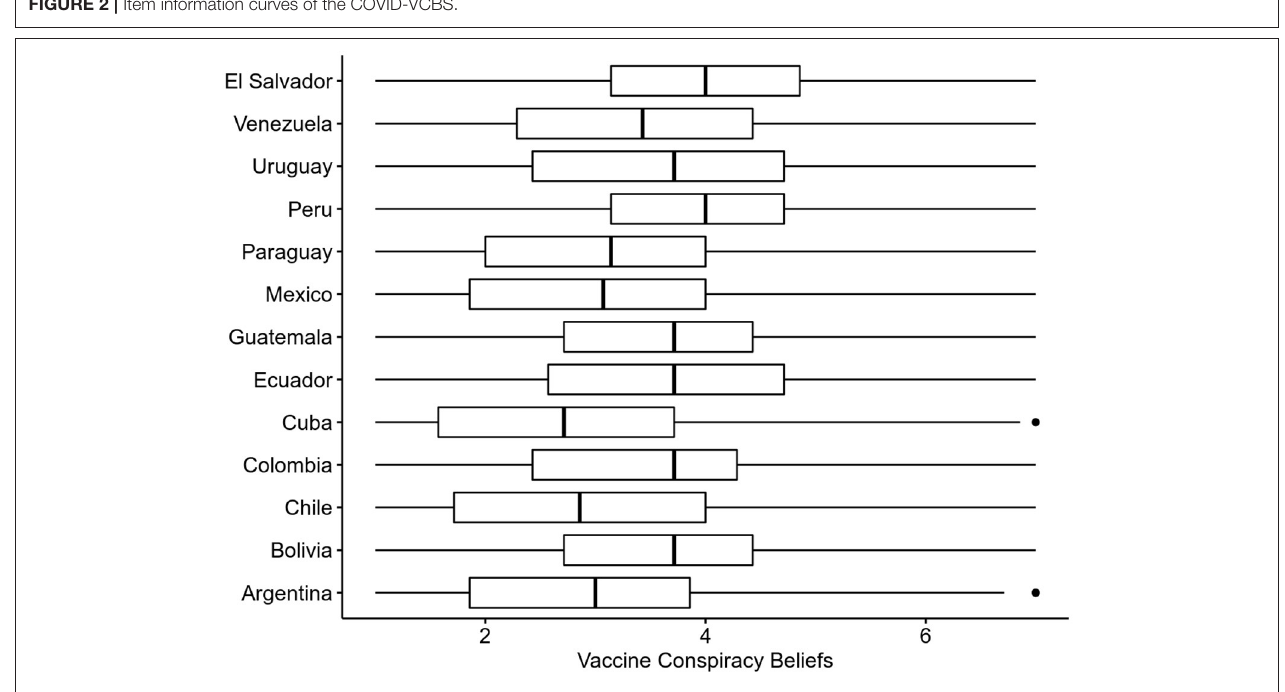
FIGURE 3 | Boxplots comparing the observed scores of the COVID-VCBS across countries. with data reported from other sources, such as, for example, interviews and/or information obtained from close